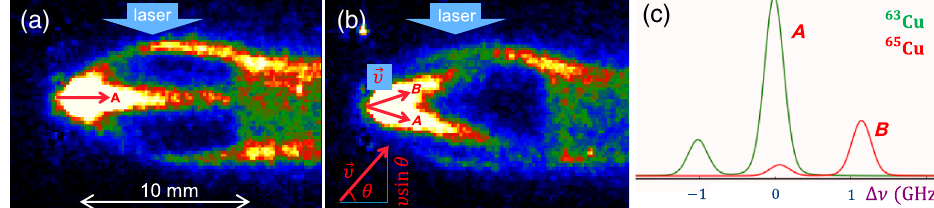
¼ 0 . 9 mbar. Red bg